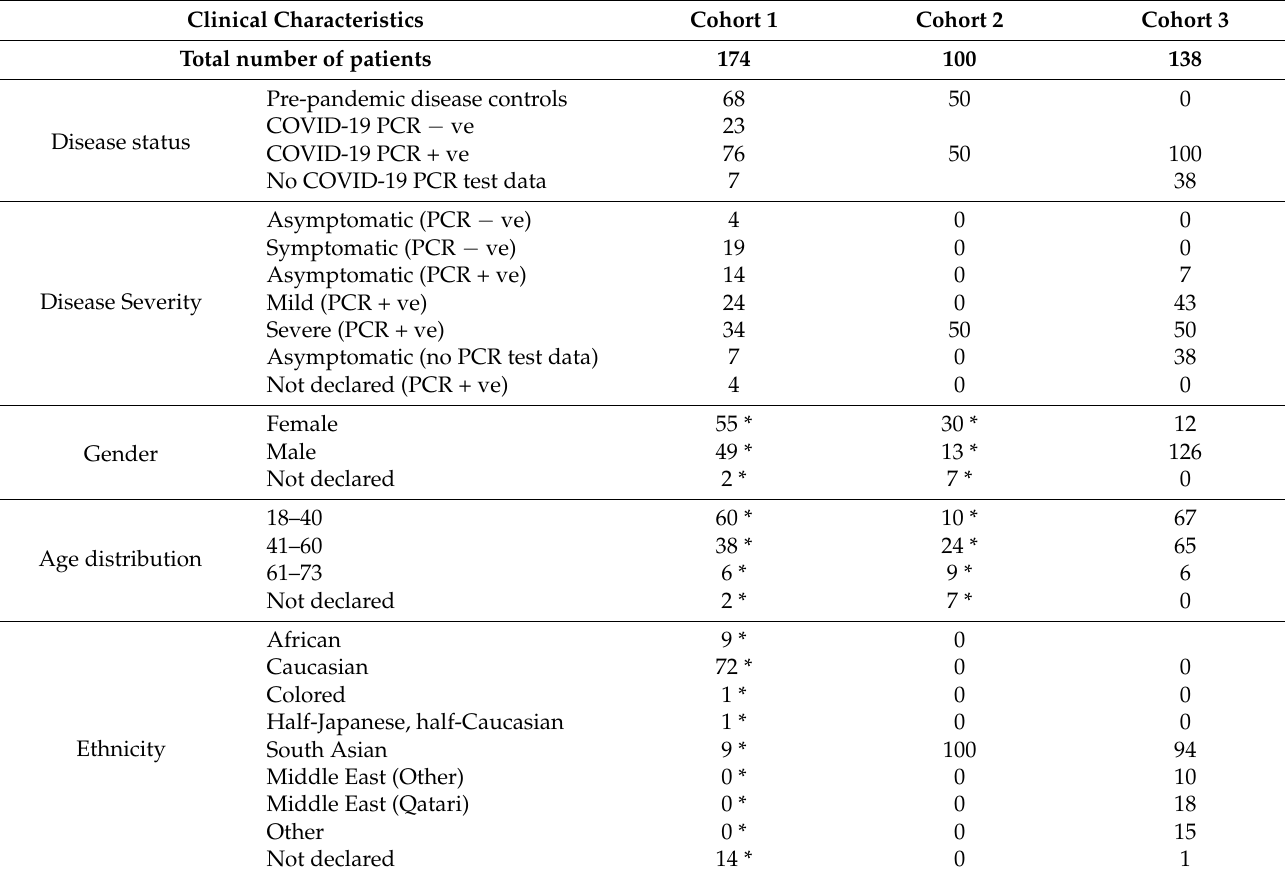
Table 1. Clinical characteristic of COVID-19 patient